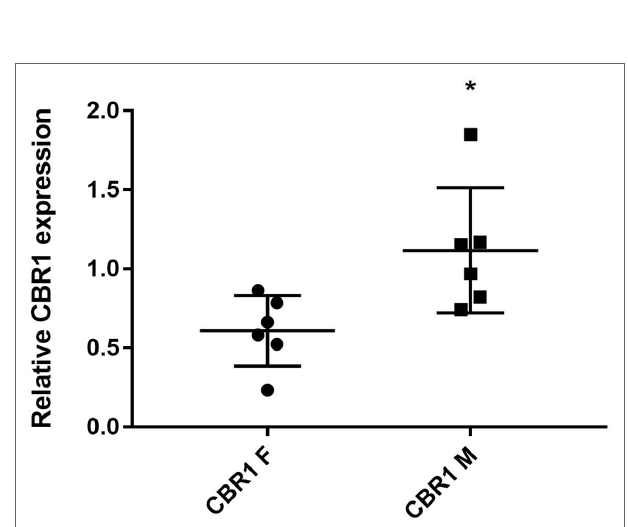
FIGURE 6 | The levels of CBR1 in liver cytosol from individual human samples [F, female (n = 6); M, male (n = 6)]. Protein levels were measured in two independent experiments. *Significantly different compared with F.